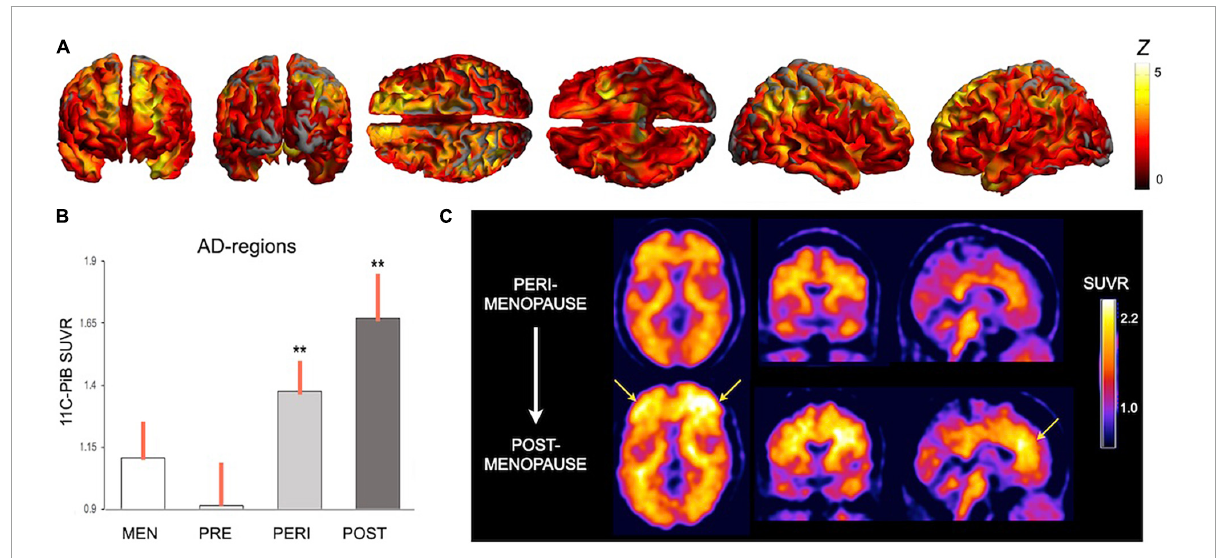
FIGURE2 Effects of menopause on brain amyloid-beta deposition. Summary of Pittsburgh compound B PET (PiB-PET) studies showing menopause status effects on A β deposition: (A) Statistical parametric maps showing higher PiB uptake, a marker of A β load, in key brain regions for AD in a group of post-menopausal and peri-menopausal women vs. age-controlled men (Z scores > 2 correspond to p < 0.001). (B) In these regions, A β load was associated with menopausal status, e.g., was highest post-menopause, intermediate in peri-menopause, and lowest pre-menopause (**different from men at p < 0.001). (C) A β deposition is progressive during the menopause transition, as evidenced in a representative case who underwent PiB-PET at baseline, when she was peri-menopausal, and 3 years later, when she was post-menopausal. Images are adapted from data presented in (A) Mosconi et al. (2021), (B) Mosconi et al. (2017), and (C) Mosconi et al. (2018b). PiB, Pittsburgh compound B; SUVR, standardized uptake value